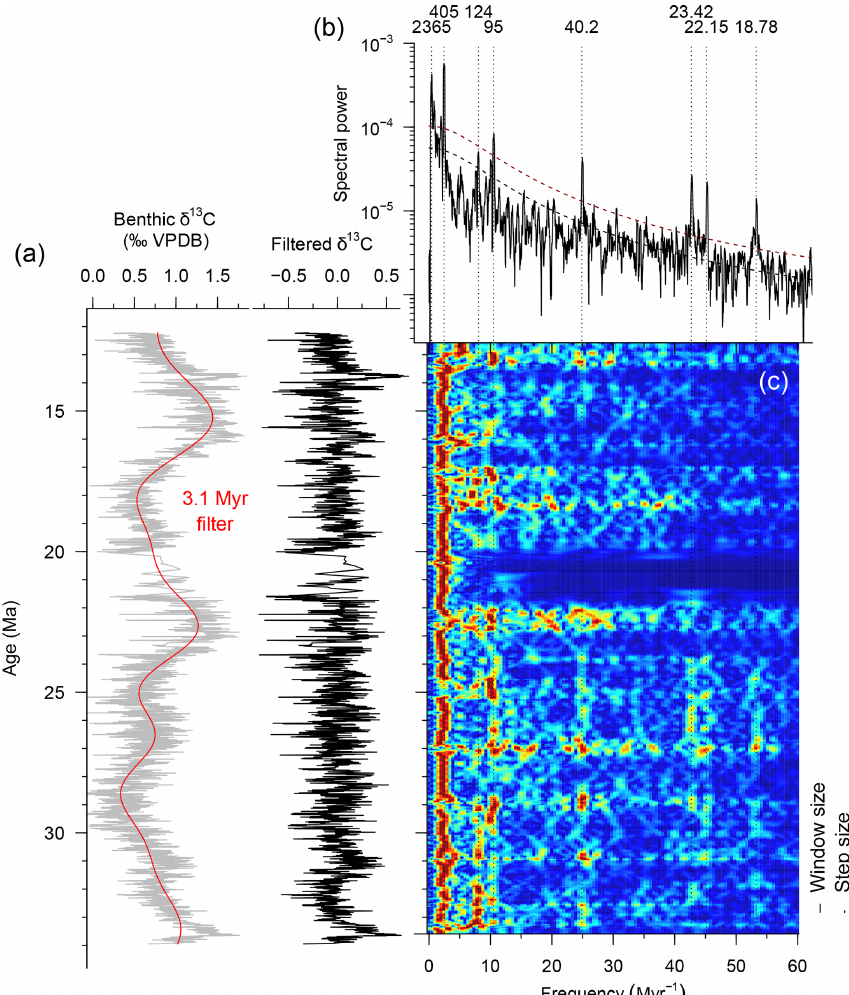
Figure 6. Evolutive multitaper harmonics analysis (c) of the data composite δ 13 C (grey) after detrending (black) the < 1Myr signal (red line) in the time (a) and frequency (b) domains. Periods of interest are labelled (b) on the same axis as (c) . A window size of 0.7Myr was used, with a step size of 10kyr (lines on the right side in c ). Methods adapted from Pälike et al.